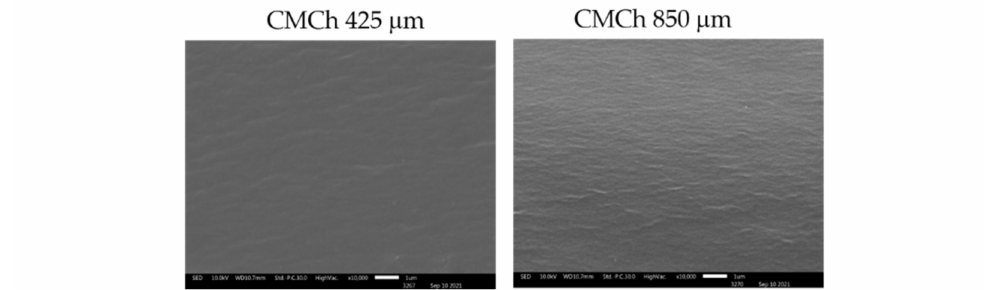
Figure 6. Morphology of CMCh powders.